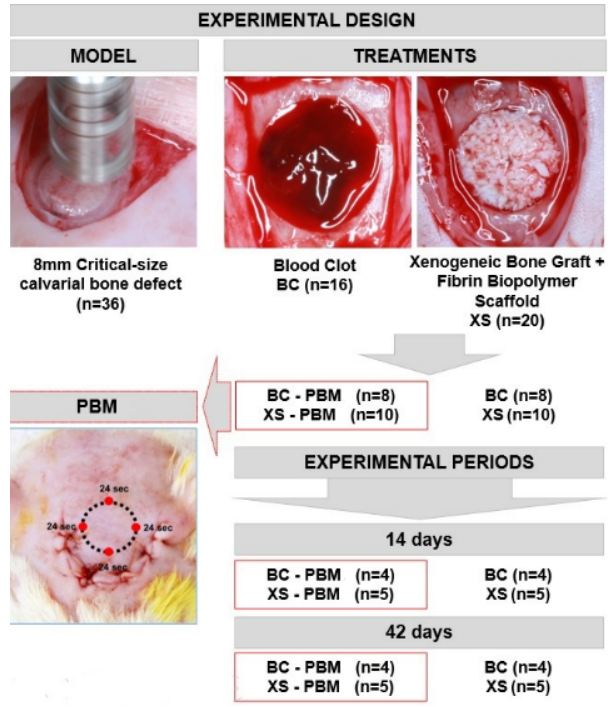
Figure 2. Experimental design. Thirty-six male Wistar rats underwent a critical bone defect in the center of the parietal bones with a no. 8 drill. In 16 animals, the defect was filled with a blood clot from an intracardiac puncture. In 20 animals, a biocomplex formed by the granulated biomaterial Bio-Oss TM was incorporated into the fibrin biopolymer (CEVAP/UNESP). The groups were constituted as follows: blood clot group (BC, n = 8), defect filled with blood clot obtained from the animal itself by cardiac puncture; blood clot with PBM group (BC-PBM, n = 8), defect filled with blood clot associated with PBM; xenogeneic bone graft + fibrin biopolymer scaffold group (XS, n = 10), defect filled with the association of the xenogenic biomaterial with the fibrin biopolymer; xenogeneic bone graft + fibrin biopolymer scaffold with PBM group (XS-PBM, n = 10), defect filled with the association of the xenogenic biomaterial with the fibrin biopolymer associated with PBM. PBM was performed at four points in the form of a cross, for 24 seconds at each point, using the GaAlAs laser (Ibramed TM